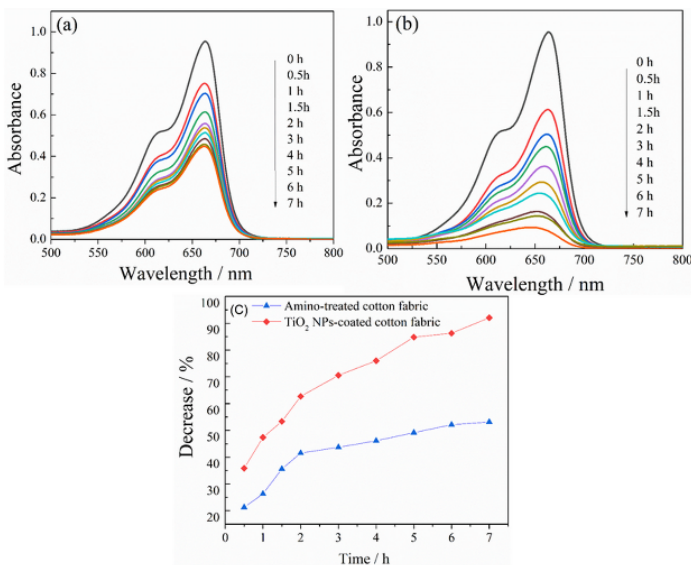
Figure 6. The absorbance of methylene blue by ( a ) amino-treated cotton fabric, ( b ) TiO 2 NPs-coated cotton fabric under UV-light, and ( c ) the decrease rate of methylene blue by amino-treated and TiO 2 NPs-coated cotton fabric.